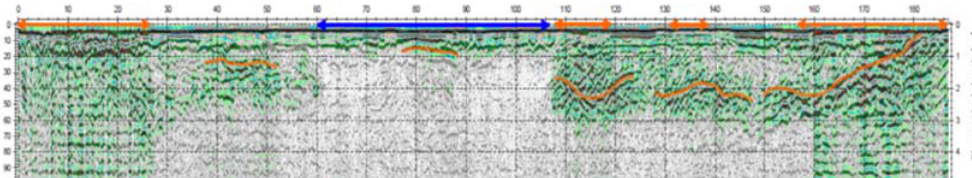
Figure 4. Distribution of apparent el. resistivity as surveyed with CMD.